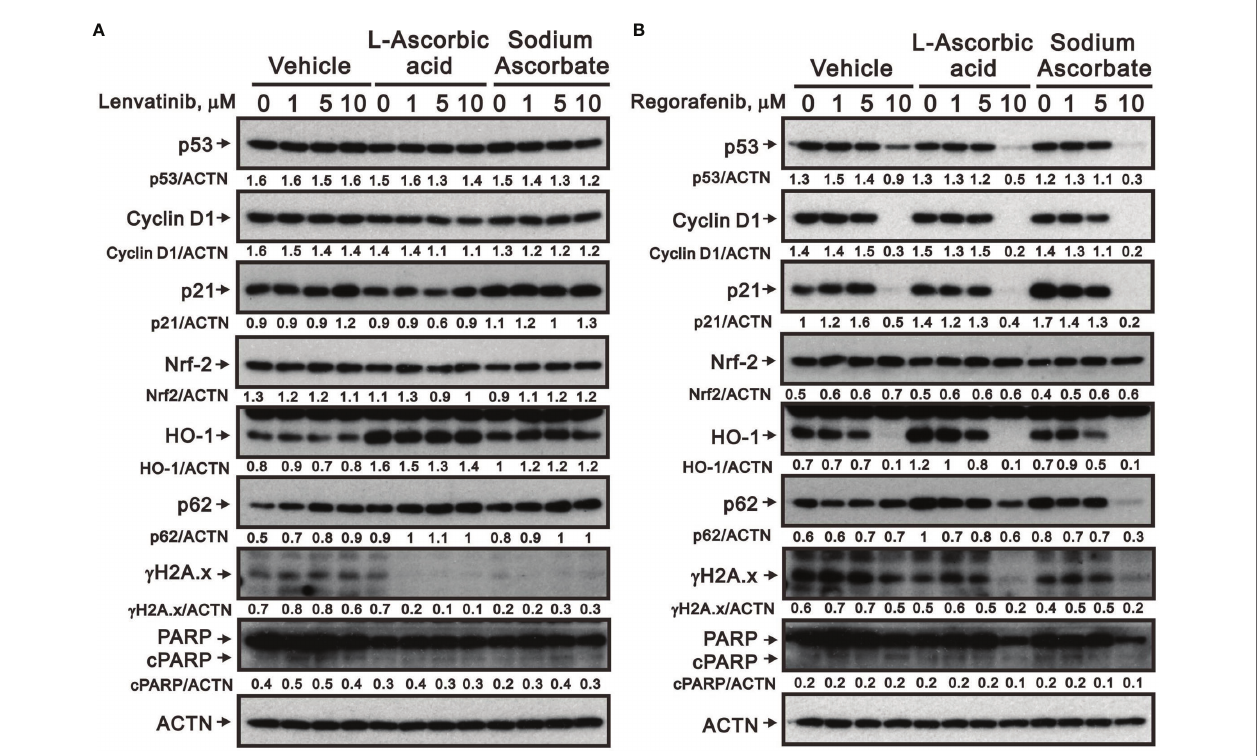
FIGURE 5 | Effects of ascorbate combined with TKIs on speci fi c protein expressions in HepG2 cells. HepG2 cells (4 × 10 5 ) were treated for 24 h with the indicated concentrations of (A) lenvatinib or (B) regorafenib in the absence or presence of 5-mM L -AA or sodium ascorbate. Cell lysates were subjected to Western blot analysis using antibodies against the indicated proteins. ACTN was the protein loading control. Protein bands were quanti fi ed through pixel density scanning and evaluated using ImageJ, version 1.44a (http://imagej.nih.gov/ij/). We show one representative